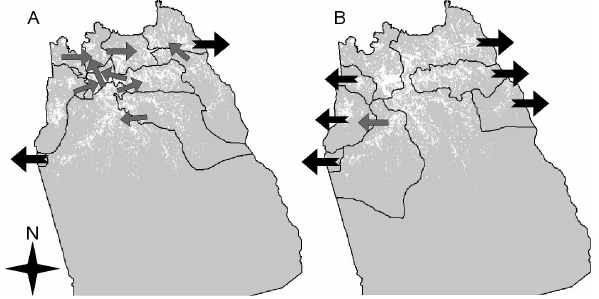
Fig. 3. Examples of different evacuation scenarios depending on the zonation criteria. (A) Here only two exit points (big black arrows) are established. The evacuation flow is similar to the behaviour of daily traffic. Almost the entire population is evacuated through a north-east point. This scenario is more complex and requires a higher evacuation time. (B) This scenario uses different exit points, the nearest inhabited areas. It facilitates the process of evacuation and reduces the evacuation times.